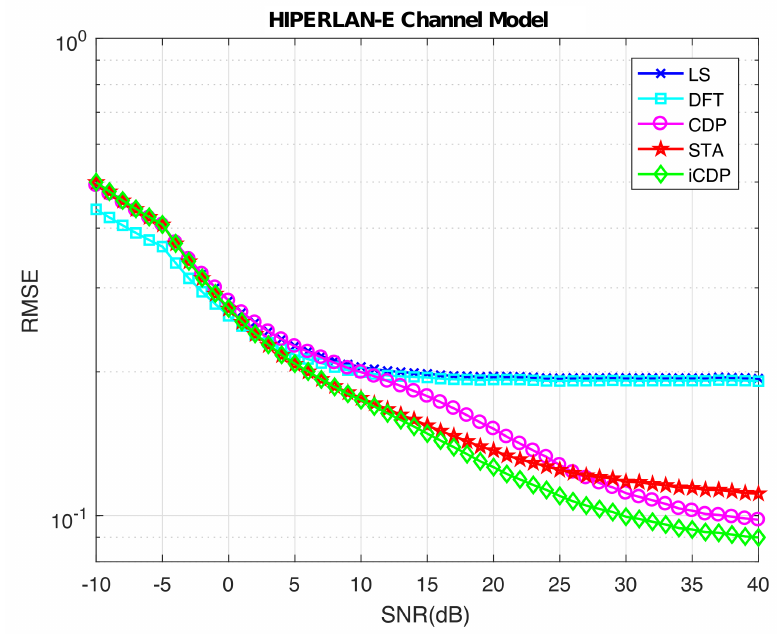
Figure 9. Root-mean-square error (RMSE) comparison for HIPERLAN-E channel model with Data Symbols =